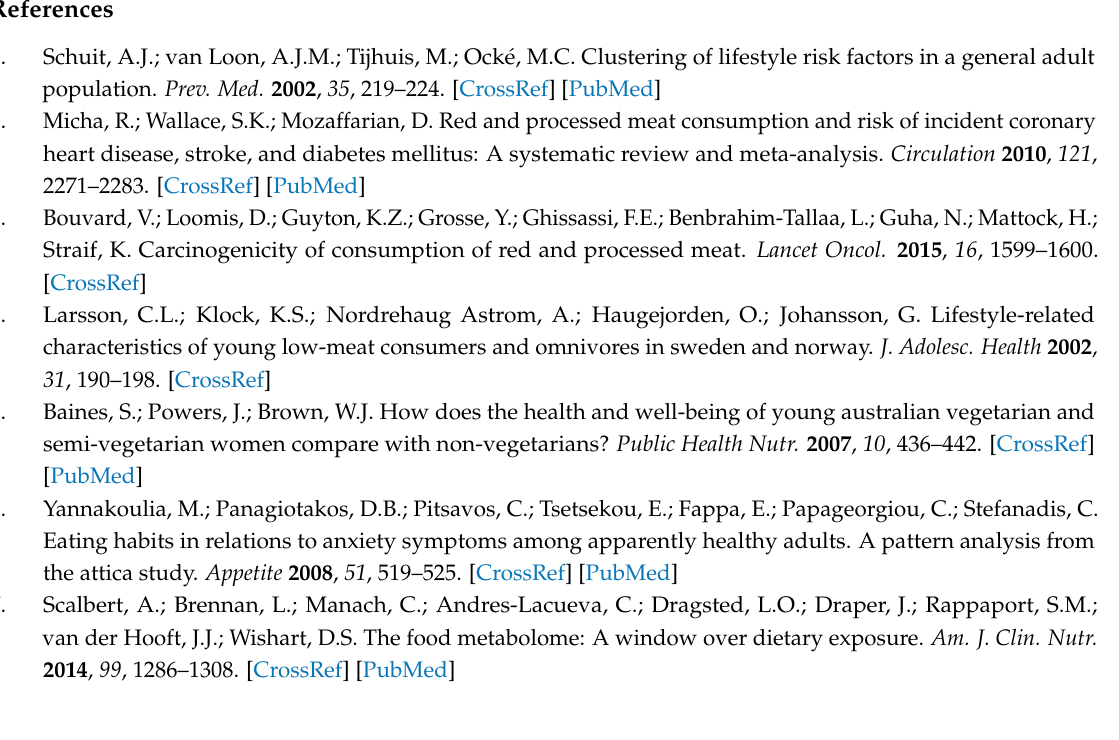
Table S1: Meal composition of omnivore breakfast, Table S2: Meal composition of lacto-ovo vegetarian breakfast, Table S3: Meal composition of vegan breakfast, Table S4: Nutrients content of breakfast meals, Table S5: Model statistics discriminant analysis and effect projections, Table S6: Classification of prediction set in O2PLS-DA models, Table S7: Change in concentration of identified metabolites between fasting and postprandial samples for vegan-, lacto-ovo vegetarian-, and omnivore